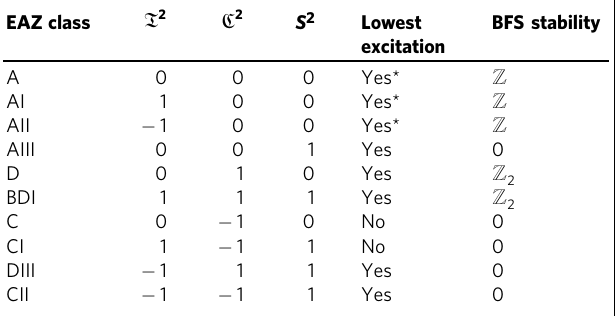
Table 1 Tenfold way classi fi cation of the lowest optical excitations in